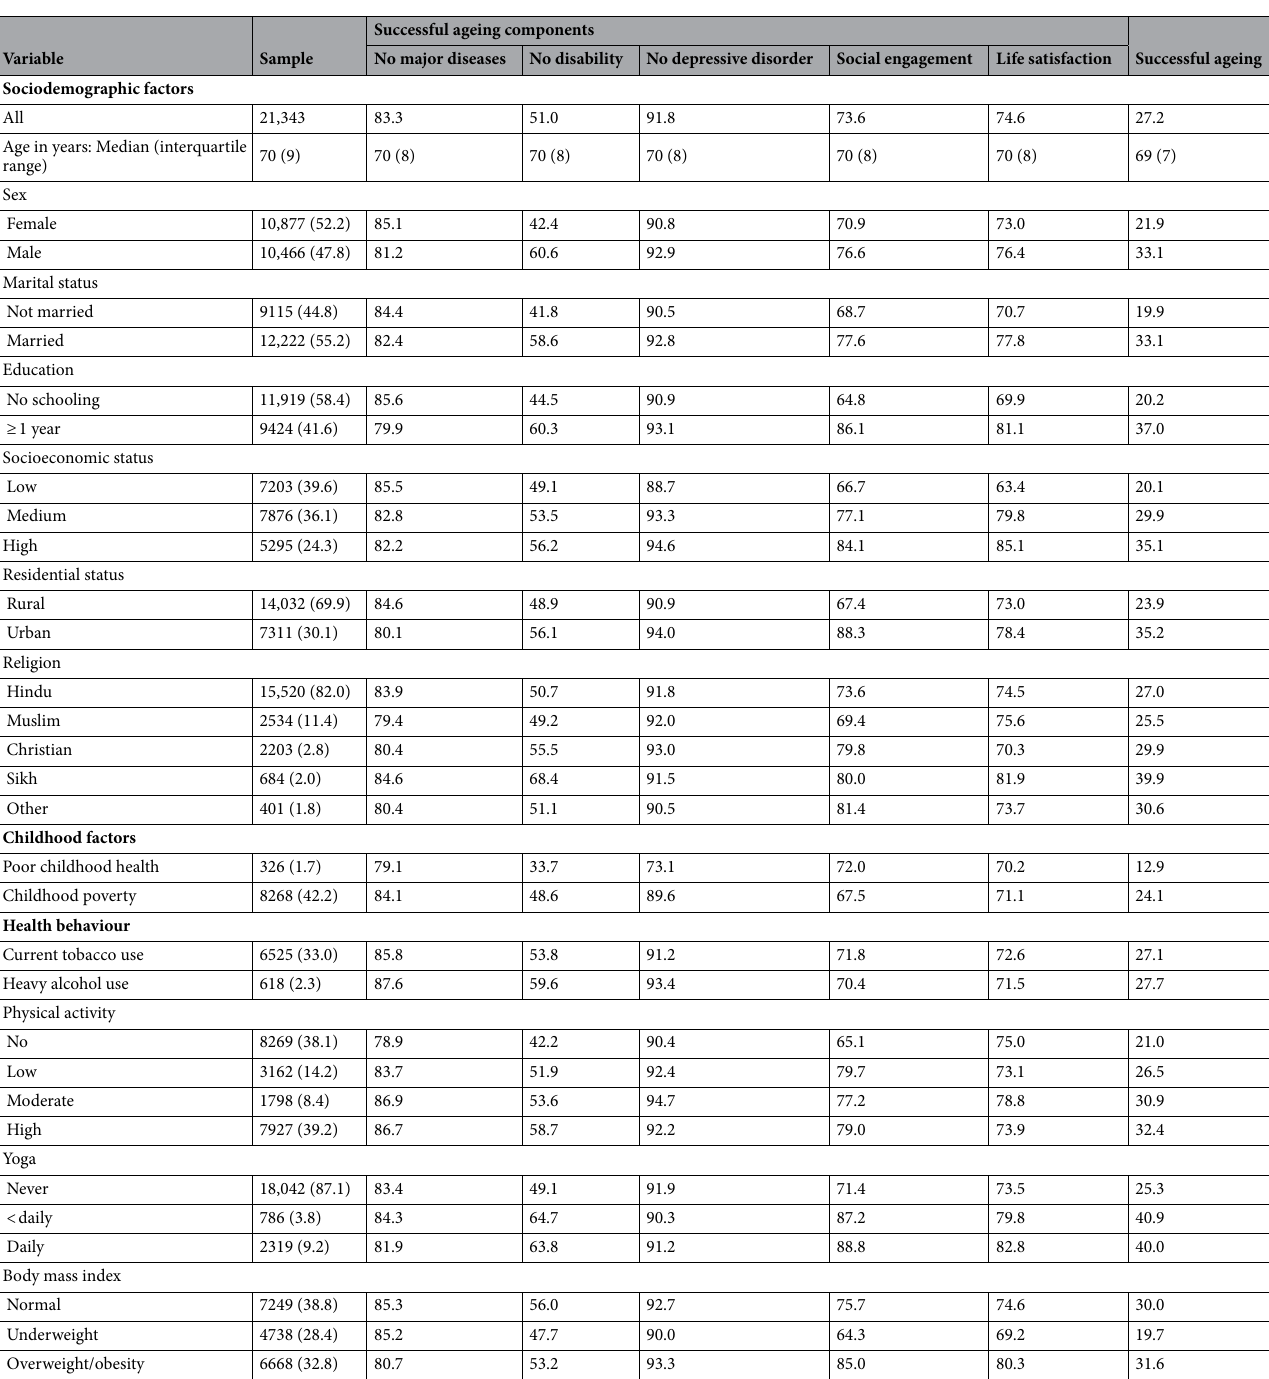
Table 1. Sample and successful ageing characteristics in percent among older adults (≥ 65 years) in India,